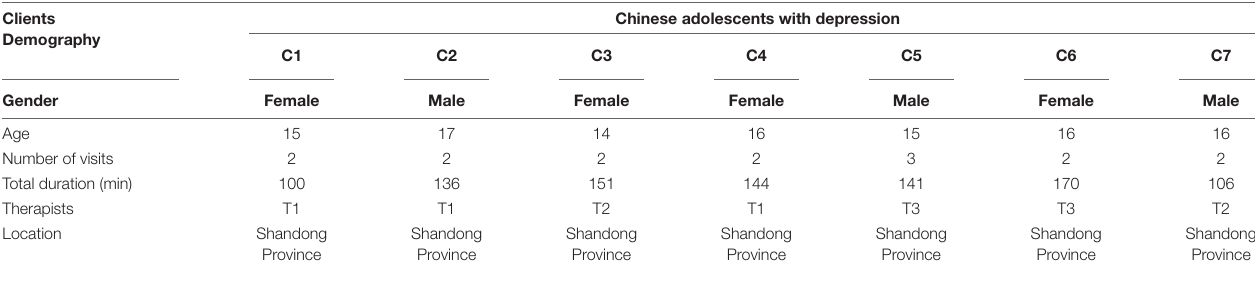
TABLE 1 | Demographic information about Chinese adolescents with depression. Clients